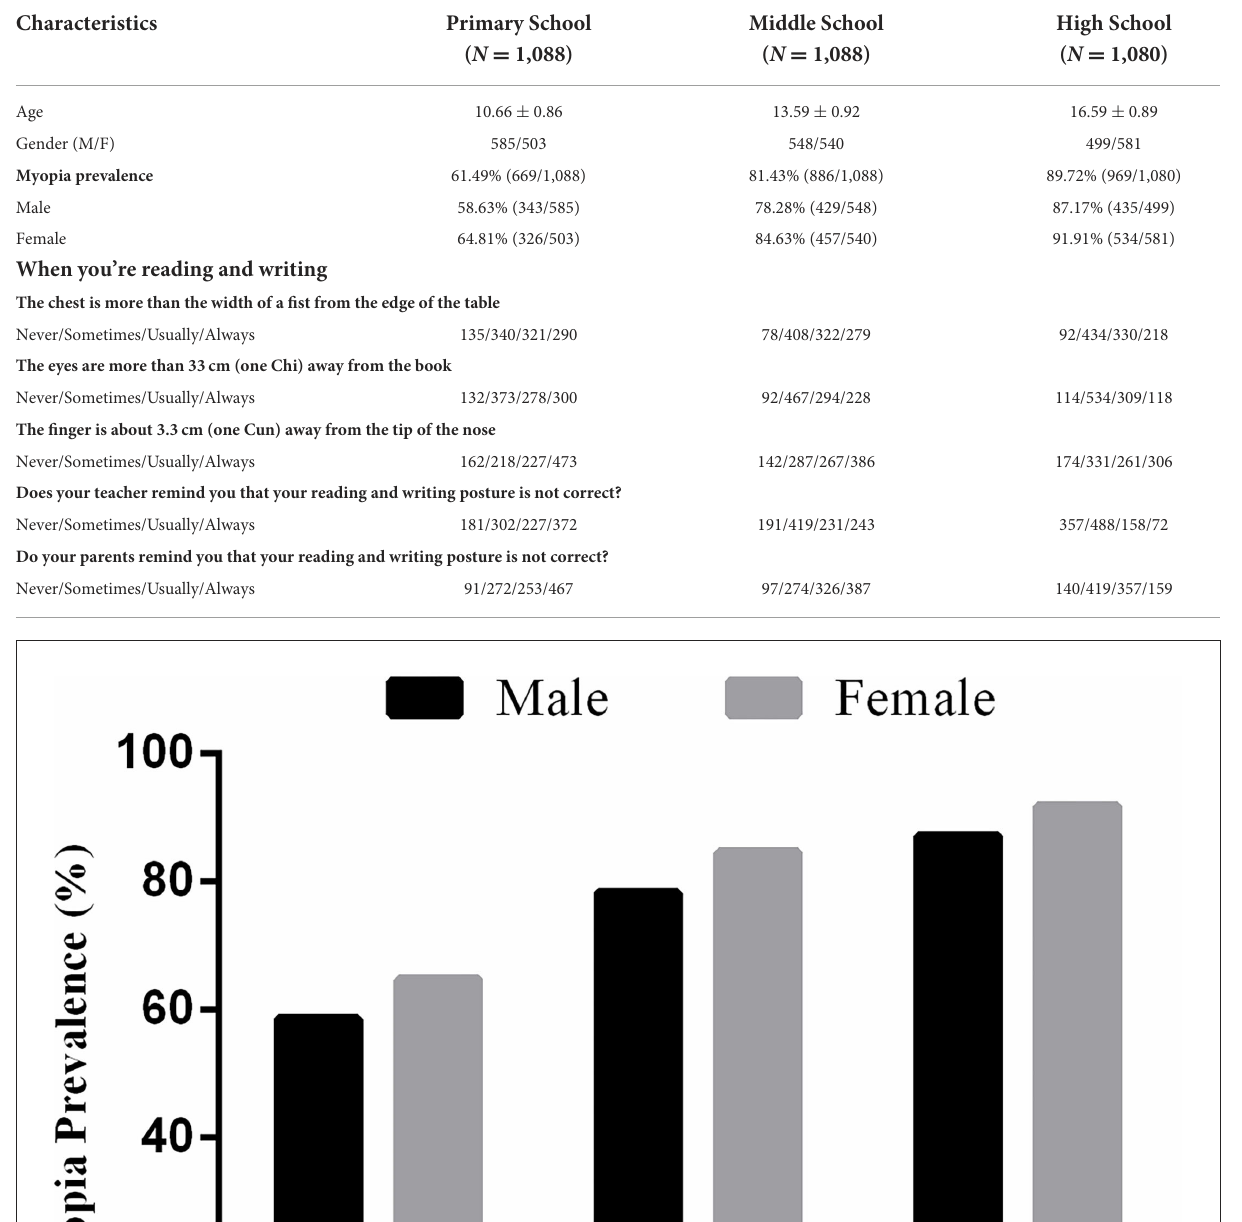
TABLE 1 Characteristics of all subjects included in the study.